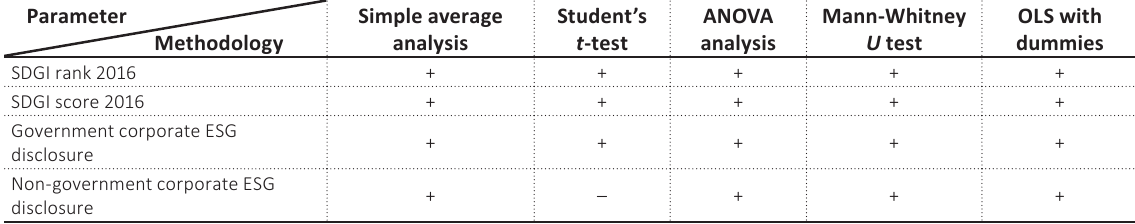
Table 3. Overview of the empirical results for H1